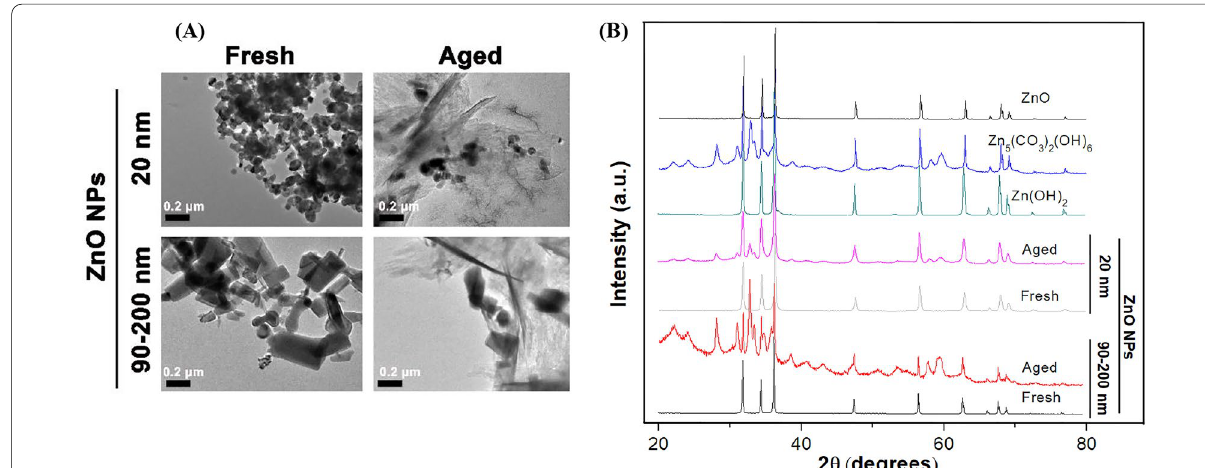
Fig. 1 Physicochemical characteristics of fresh and aged ZnO NPs. A Representative micrographs of fresh and aged NPs (100 μg/mL, 20 and 90–200 nm) in Milli- Q water using low resolution TEM, B XRD patterns of fresh NPs, aged NPs, ZnO, Zn (OH) 2 and Zn 5 (CO 3 ) 2 (OH) 6 references in dried